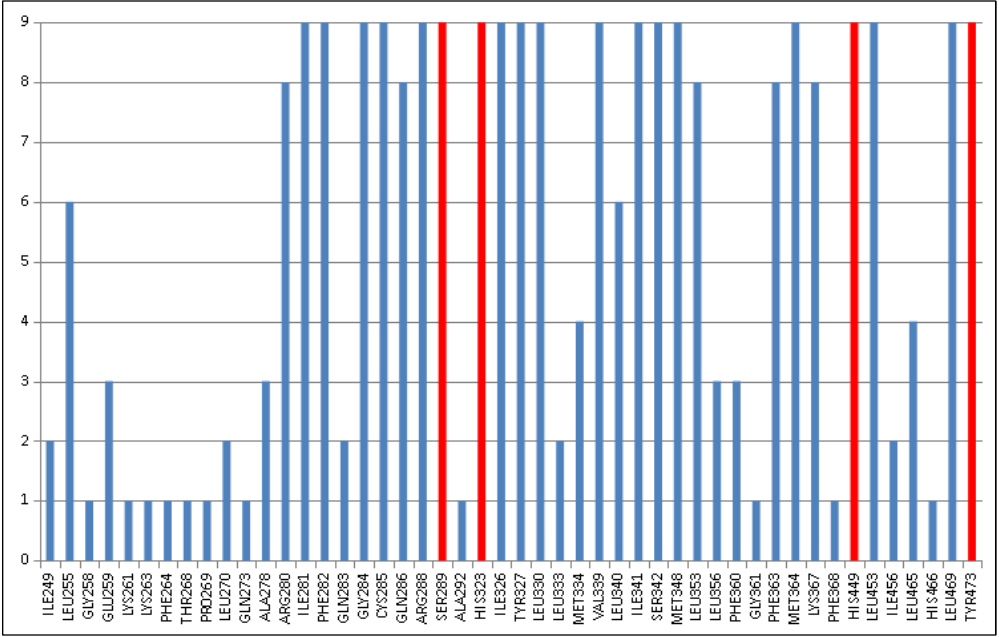
Figure 5. The number of occurrences of the amino acids involved in the binding pockets of the nine most active agonists (according to the EC the amino acids that were identified to form hydrogen bonds (HBs) with the most active